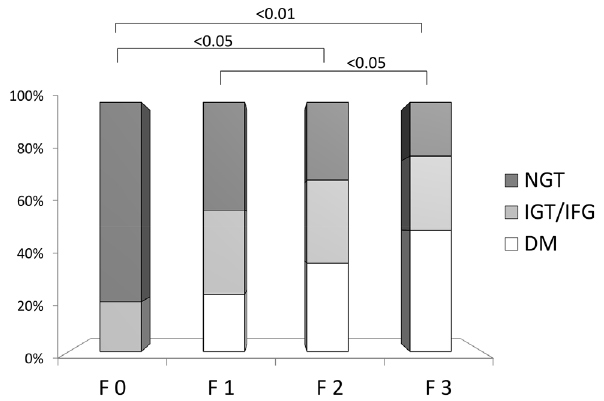
Figure 1. Relationship between glucose impairment and progression of hepatic fibrosis. The frequencies of NGT, IGT/IFG, and T2DM in the four stages of hepatic fibrosis are shown. The diagnosis of glucose impairment was based on the 75gOGTT. The prevalence of NGT in patients in the F0 group (80.0%) was significantly higher than that in the F1 (43.2%), F2 (31.3%), and F3 groups (21.6%), and the frequencies of patients with T2DM in the F3 group (48.6%) was significantly higher than that in the F0 (0%), F1 (22.9%), and F2 (35.4%) groups. P -values were calculated using the X 2 -test. Fibrosis stage (F): F0 ( n =10), F1 ( n =74), F2 ( n =48), F3 ( n =37); total,